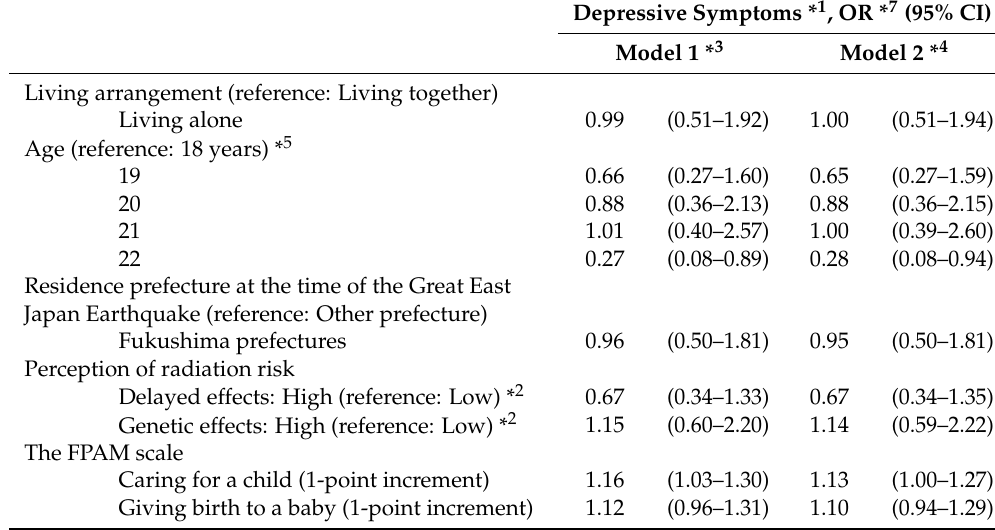
Table 4. Logistic regression analysis of depressive symptoms in the negative and positive groups * 6